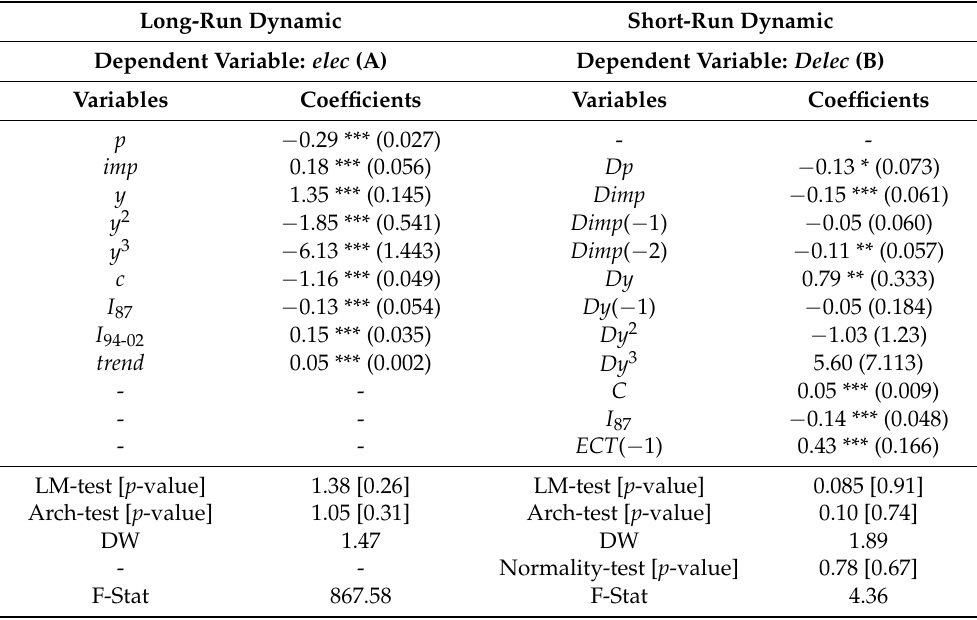
Table 4. Estimates of long-run dynamic and short-run